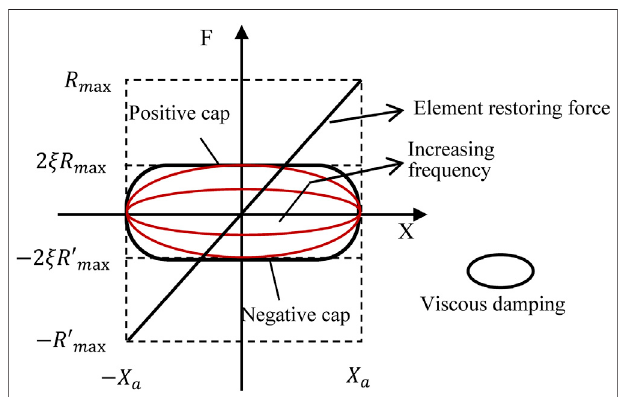
FIGURE1| Elementforceandviscousdampingforcesvs.displacement for a single-degree-of-freedom oscillator under harmonic motion with increasingfrequencyat constantdisplacementamplitude X : R max ismaximum restoring force of spring. [presented by Hall (2018)].